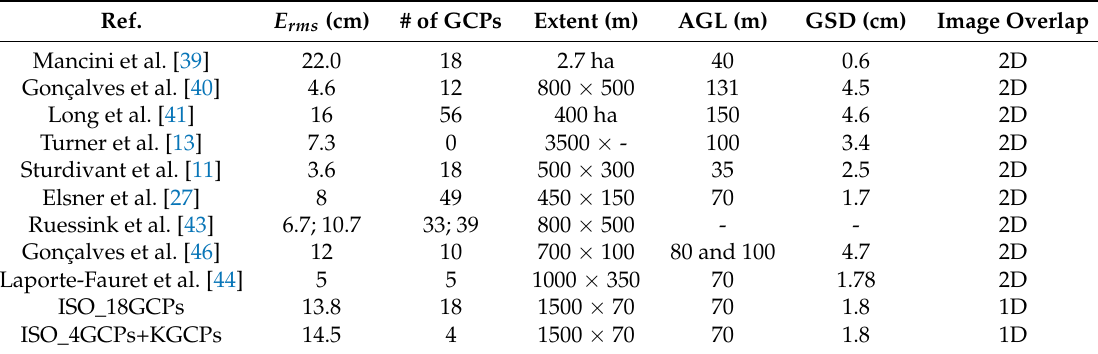
Table 3. Comparison of photogrammetric performance with selected coastal topography applications, in terms of root mean square errors ( E rms ), as a function of the number of GCPs per surveyed area/extent, of above ground flight level (AGL), of Ground Sampling Distance (GSD) and of image overlap, in one or two horizontal